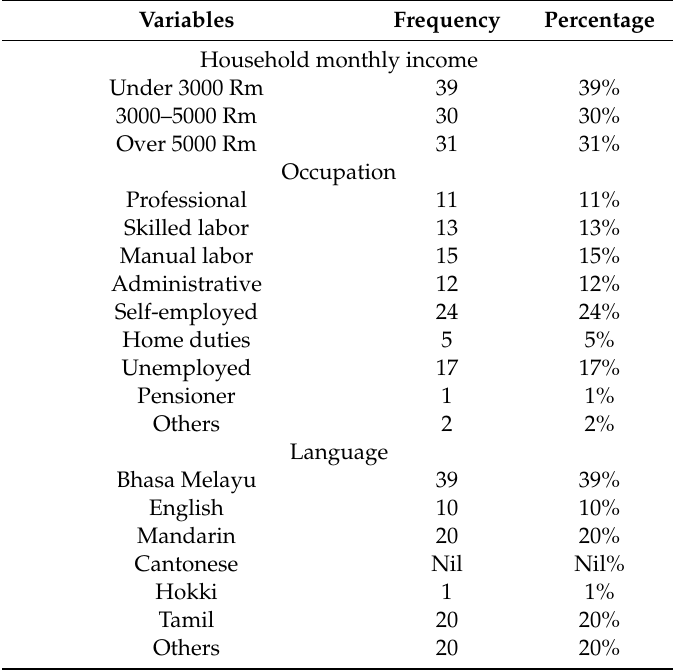
Table 2. Socio-demographic characteristics of study